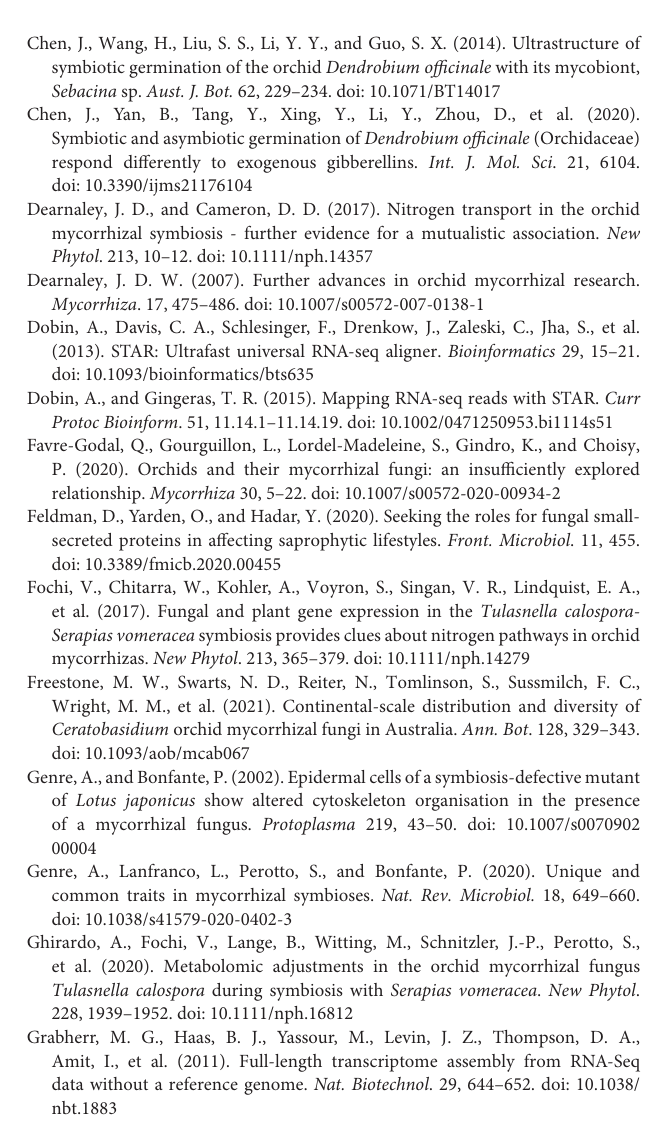
free living mycelium; (F) Functional classfication of 403 co-upregulated fungal genes of Serendipita sp. in symbiotic status compared to free-living mycelium. Supplementary Figure S2 | Cluster analysis of 936 fungal orthologous differentially expressed genes. All genes analyzed were divided into five clusters. F_S2, F_S3, F_S3 means Serendipita sp. in symbiotic statuses 2, 3, and 4 stages, and F_T2, F_T3, and F_T4 means Tulasnella sp. in symbiotic statuses 2, 3, and4 stage (according to seed germination), Ft and Fs means free-living mycelium of Tulasnella sp. and Serendipita sp., respectively. Supplementary Table S1 | Functional classification of 452 upregulated expressed plant genes across various symbiotic germination stages of D.officinale inoculated with Tulasnella sp. or Serendipita sp. Supplementary Table S2 | 25 most up-regulated common expression plant genes across germination stage whatever inoculated with Tulasnella sp. and Serendipita sp. (Fold change ≥